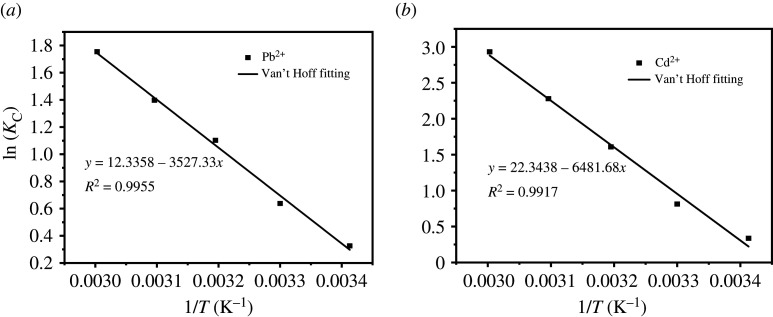
Fitting results of Kc and 1/T of Pb2+ and Cd2+.